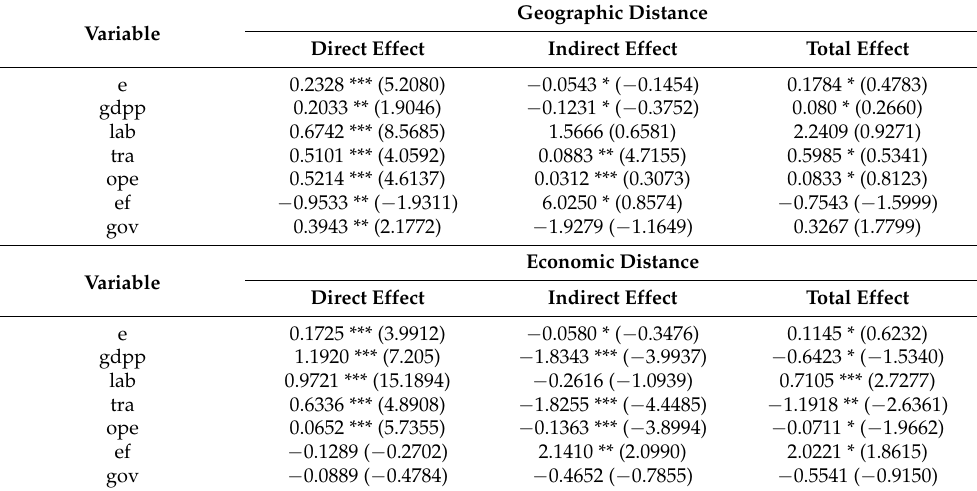
Table 5. Direct and indirect effects of